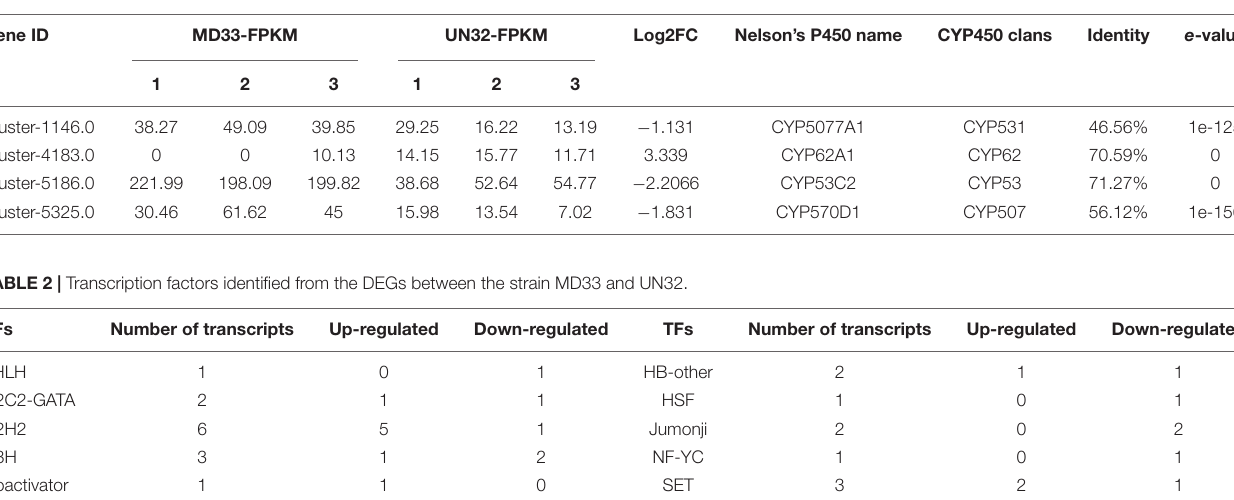
TABLE 1 | Cytochrome P450 families identified from the DEGs between the strain MD33 and UN32.